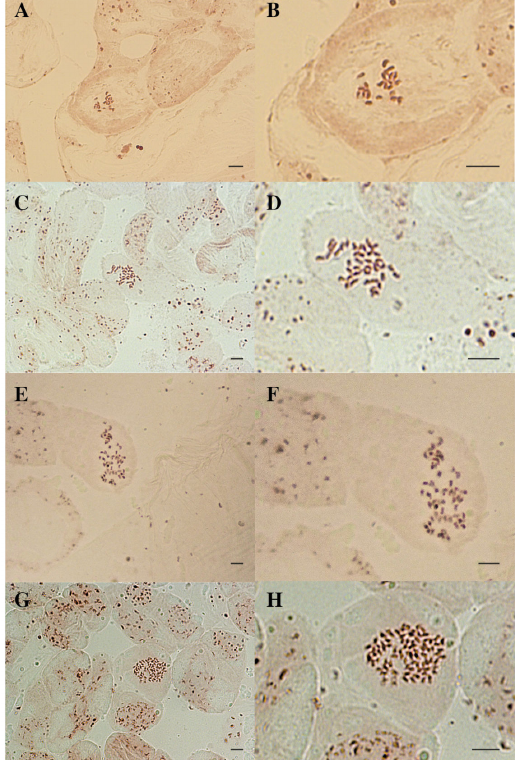
Figure 3. Metaphases in meristems of C. pepo regenerant plants of different ploidy levels: ( A , B ) hap- loid (2n = x =20); ( C , D ) diploid (2n = 2x = 40); ( E , F ) triploid (2n = 3x = 60); ( G , H ) tetraploid (2n = 4x= 80). Scale bars = 10 µ